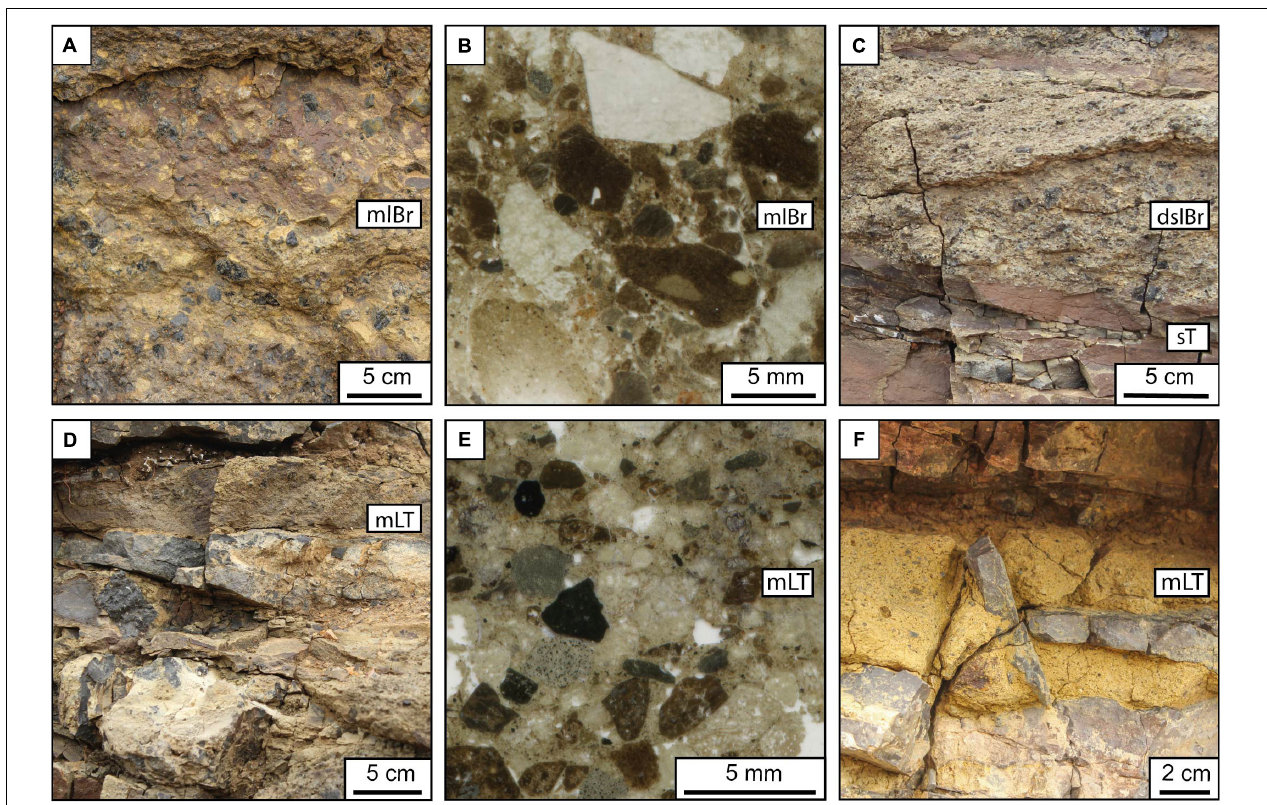
FIGURE 6 | Photographs of different facies of coarse-grained material found in the tuffisite. Labels give the facies present in each image and are also listed in brackets. (A) Massive breccia with pumice and obsidian clasts at the base of the tuffisite (Facies mlBr). (B) Thin section of a massive breccia unit (Facies mlBr). (C) Breccia unit with aligned ignimbrite clasts (Facies dsBr) with laminated tuff beneath (Facies sT) containing a coarser lens of medium lapilli grains. (D) Massive lapilli-tuff (Facies mLT) separated from the units beneath by large clasts of ignimbrite. (E) Thin section with structureless units of coarse lapilli grains (Facies mLT). (F) Yellow-orange pumiceous end member of Facies mLT, interfingered between ignimbrite